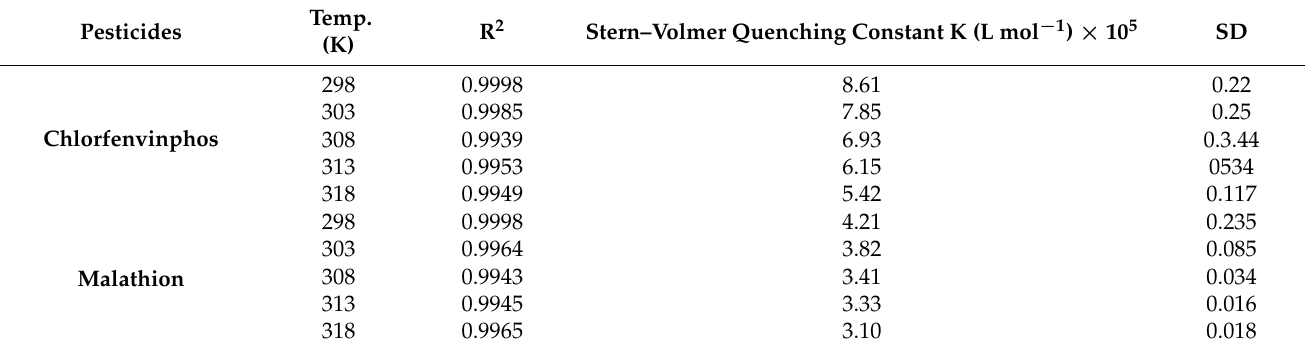
Figure 8. The F 0 /F vs. the pesticide, ( a ) chlorfenvinphos (p2) or ( b ) malathion (p8) upon its interaction with the 2.5 × 10 − 5 mol · L − 1 of Eu (III)–(vitB1) 2 complex in methanol, ( λ ex = 268 nm), at different temperatures. Table 1. The Stern–Volmer constants (K SV ) at various temperatures for 2.5 × 10 − 5 mol · L − 1 of the Eu (III)–(vitB1) 2 complex with chlorfenvinphos or malathion in methanol. Pesticides